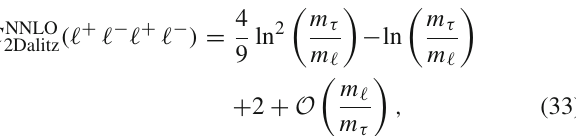
and different flavour channels. It is interesting to notice that in the asymptotic heavy- m τ limit, the coefficients for the same-flavour 4-lepton final states approach the results of